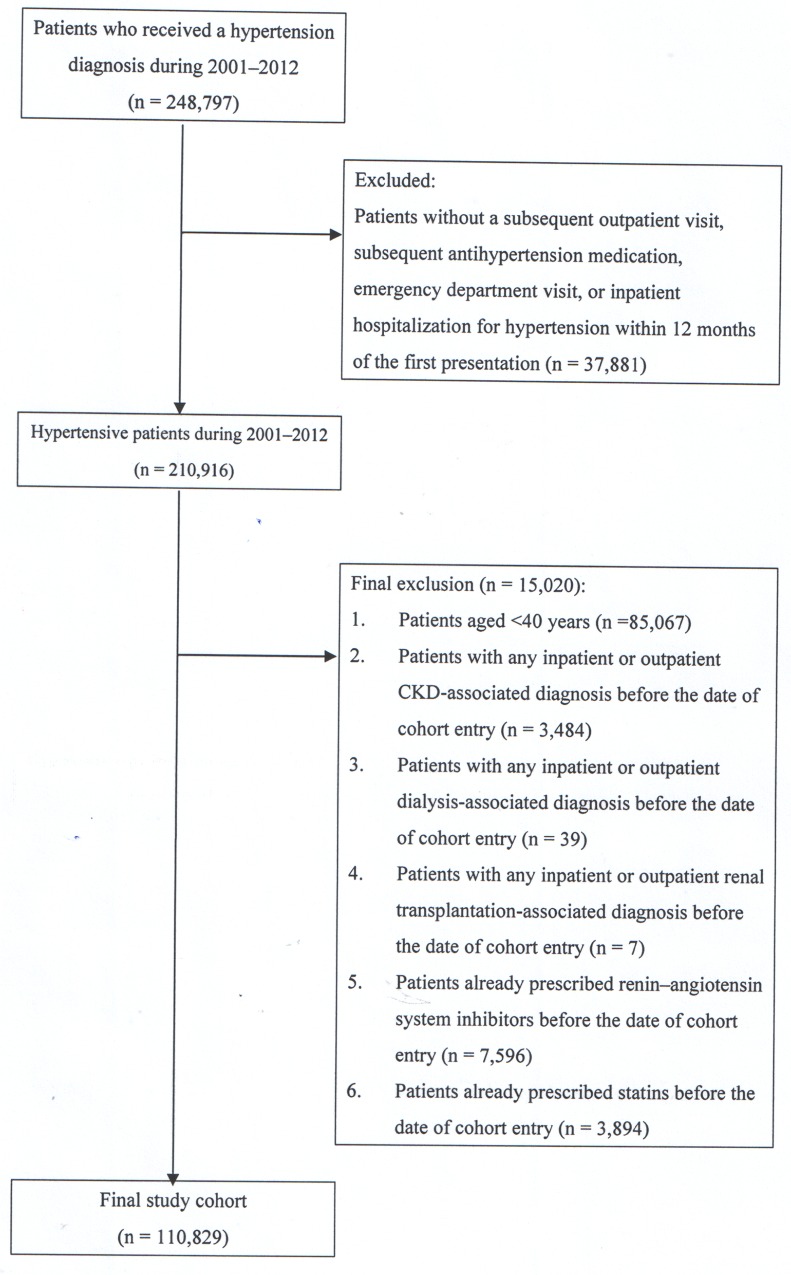
Data selection process.